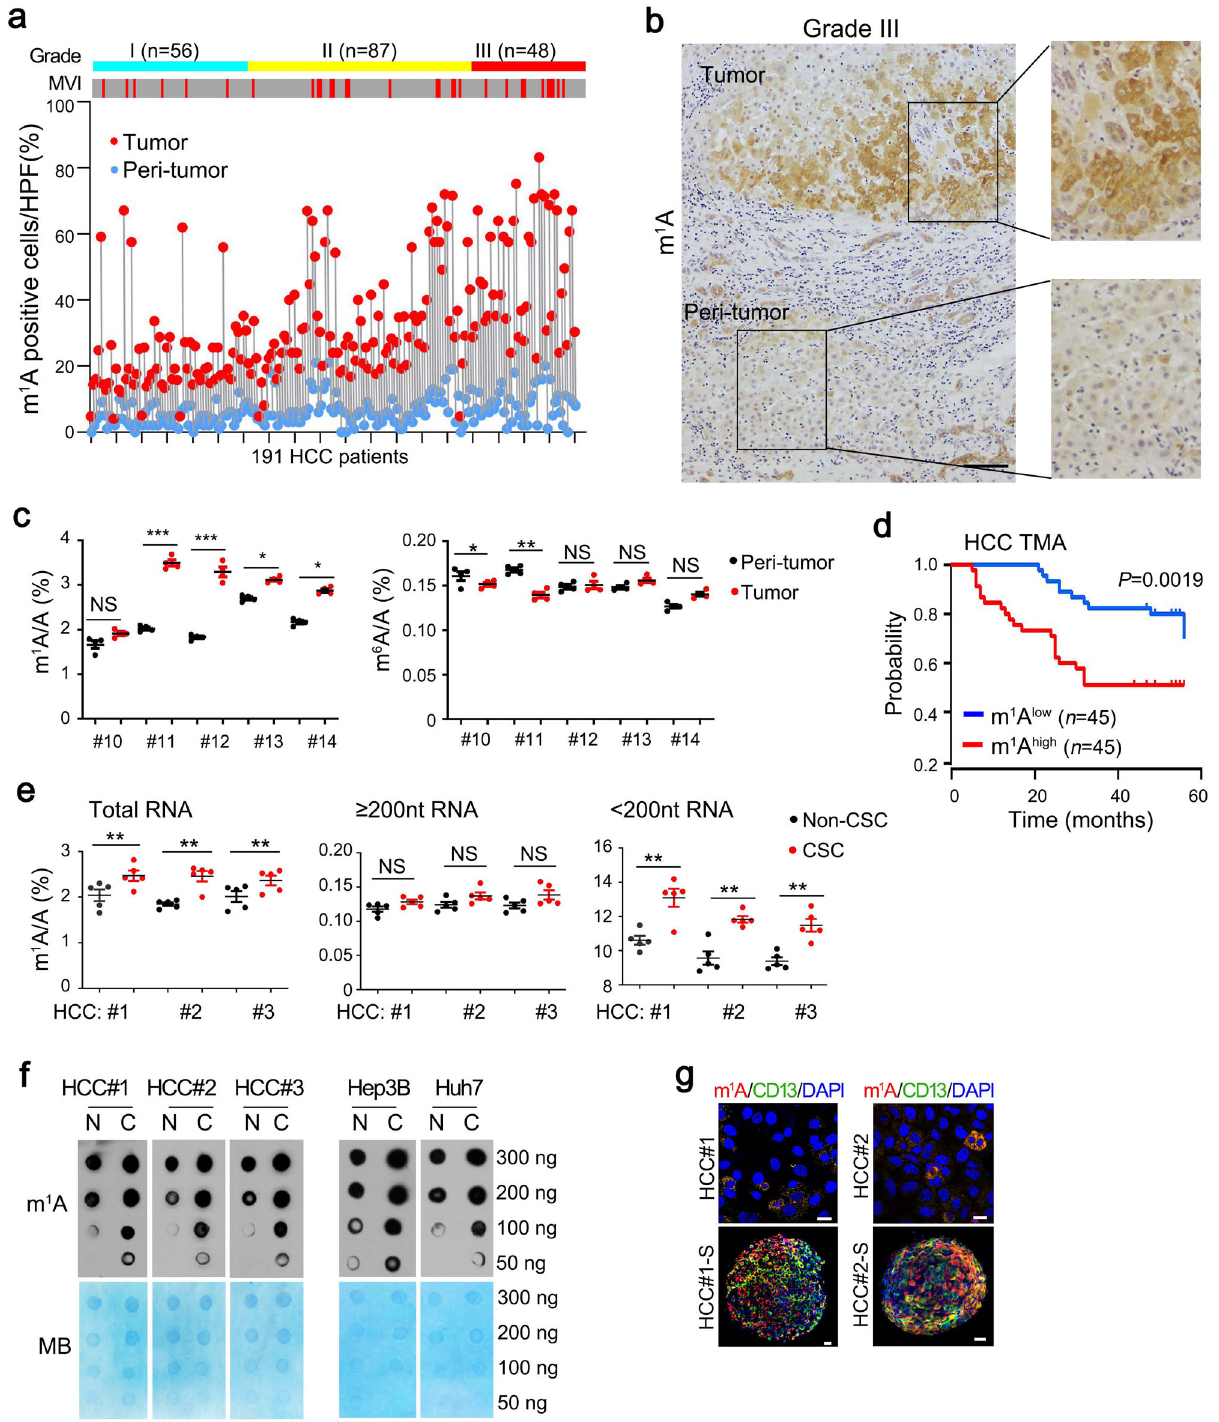
cohort (Supplementary Fig. 2c) and The Cancer Genome Atlas (TCGA) dataset (Supplementary Fig. 2d). In TCGA dataset, samples with highest levels of TRMT6 and TRMT61A in tumors exhibited advanced stages (Supplementary Fig. 2e) and worse survivals (Supplementary Fig. 2f, g). Moreover, TRMT6 was also highly expressed in CSCs of human liver cancer tissues by immuno fl uorescence staining (Supplementary Fig. 2h) and qRT- PCR analysis (Supplementary Fig. 2i). These results suggest that TRMT6 and TRMT61A are negatively correlated with a poor prognosis of